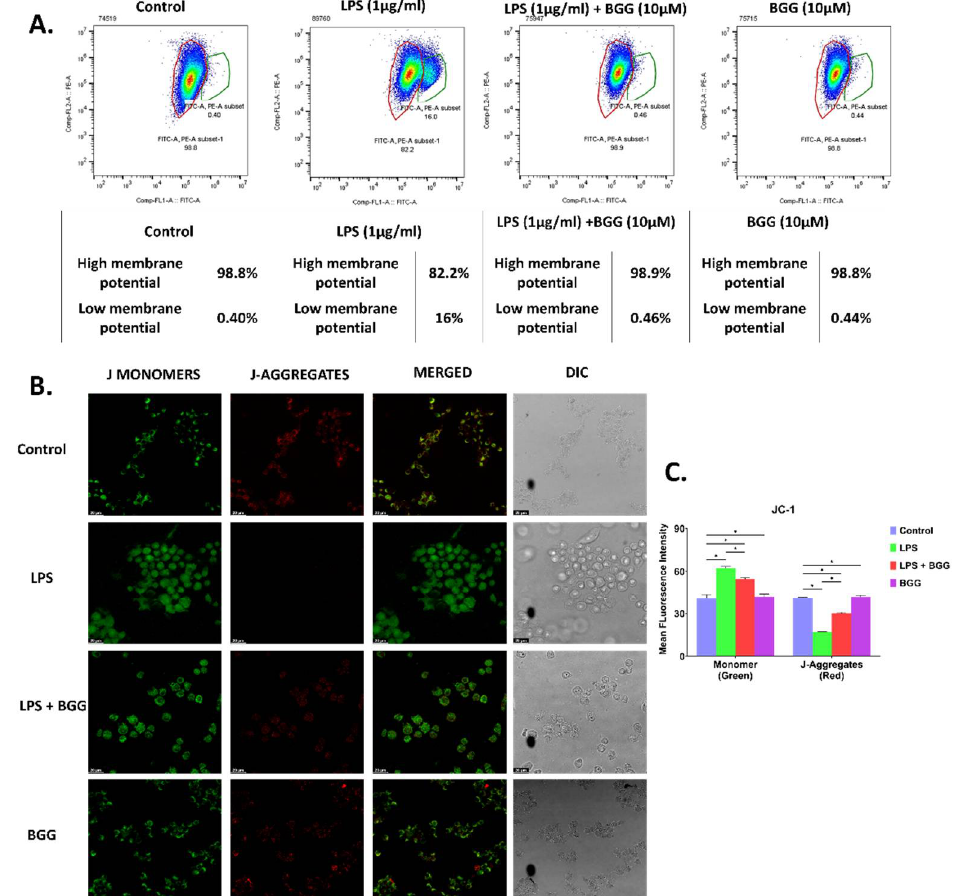
Figure 3. BGG attenuates the LPS-induced mitochondria membrane potential depolarization. RAW 264.7 cells were pre-treated with BGG (10 μM) for 1 h, followed by LPS (1 μg/mL) for 23 h of stim- ulation. ( A ) BGG attenuates the LPS depolarized membrane potential measured by flow cytometry in RAW 264.7 cells . ( B ) JC-1 staining showing BGG attenuates the LPS depolarized membrane po- tential measured by confocal microscopy in RAW 264.7 cells. ( C ) The graph represents the mean fluorescence intensity showing the J-monomer and J-aggregates measured by confocal microscopy (Mean ± SEM) ( n = 3), p -value ≤ 0.05. (* p ≤ 0.05) Both confocal and flowcytometric data confirmed that BGG pre-treatment signifi- cantly reversed the LPS-disrupted mitochondria membrane potential by incrementing red aggregates and decreasing green monomers. 2.5. Effect of BGG on LPS-Stimulated Gene Expression in RAW 264.7 Macrophages Cells RAW 264.7 cells were pre-treated for 1 h with BGG (10 μM), and then LPS (1 μg/mL) was added to the incubation medium for another 23 h. The control treatment with BGG alone lasted 24 h and LPS alone for 23 h. RNA was isolated, prepared from the four sam- ples (in duplicate), and analyzed to assess the gene expression transcriptional expression level changes. The raw data of the samples were imported from text files by using R pack- ages limma. Probes with poor signals were removed by using the signal distribution from negative control probes. The normalization of the samples was done with the R package limma using the quantile method.